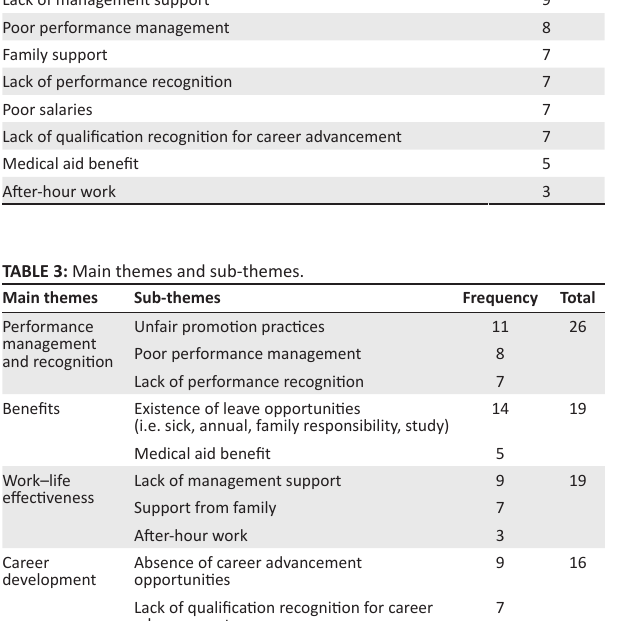
Table 3 highlights consolidated themes identified as sub-